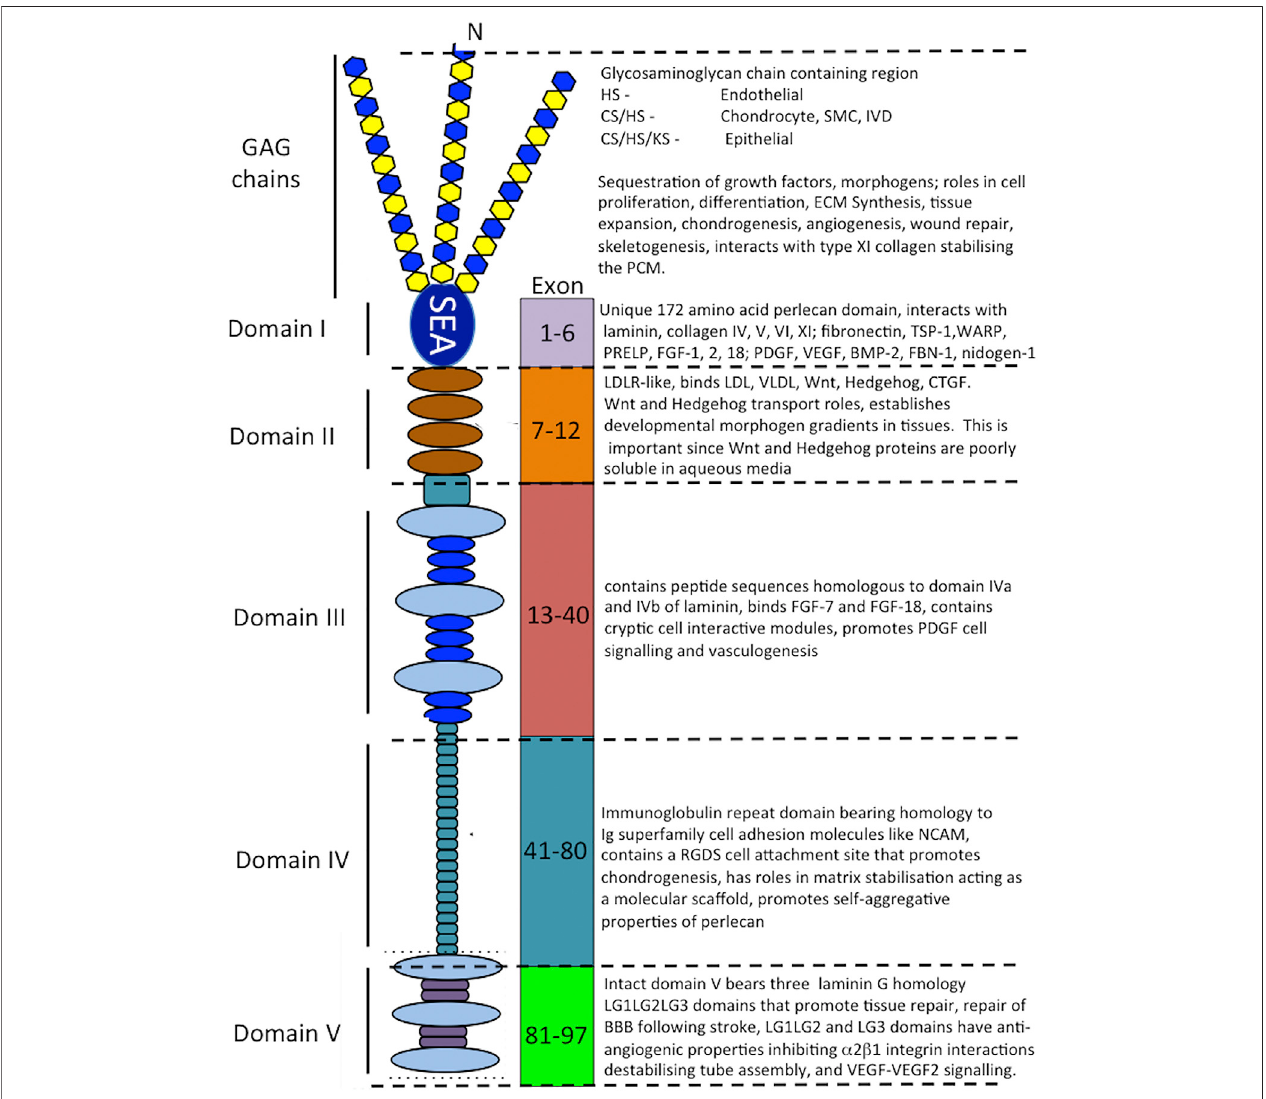
FIGURE 3 | Schematic of the modular structure of perlecan and the interactive and cell instructive properties of each of its domains.